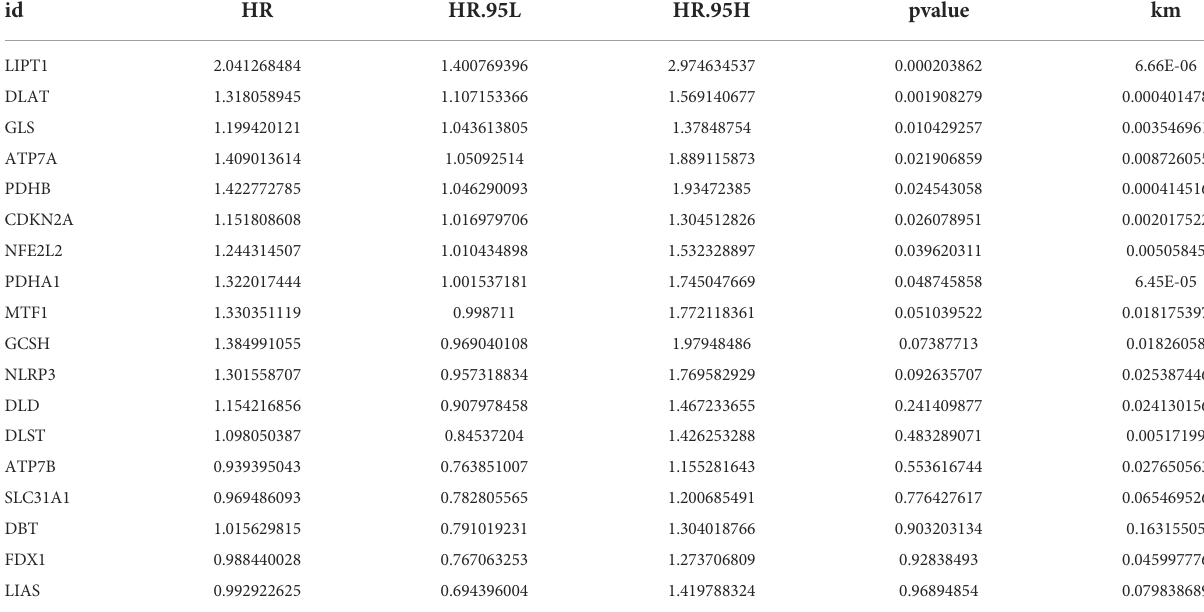
TABLE 2 UniCOX and KM analysis of CRGS.